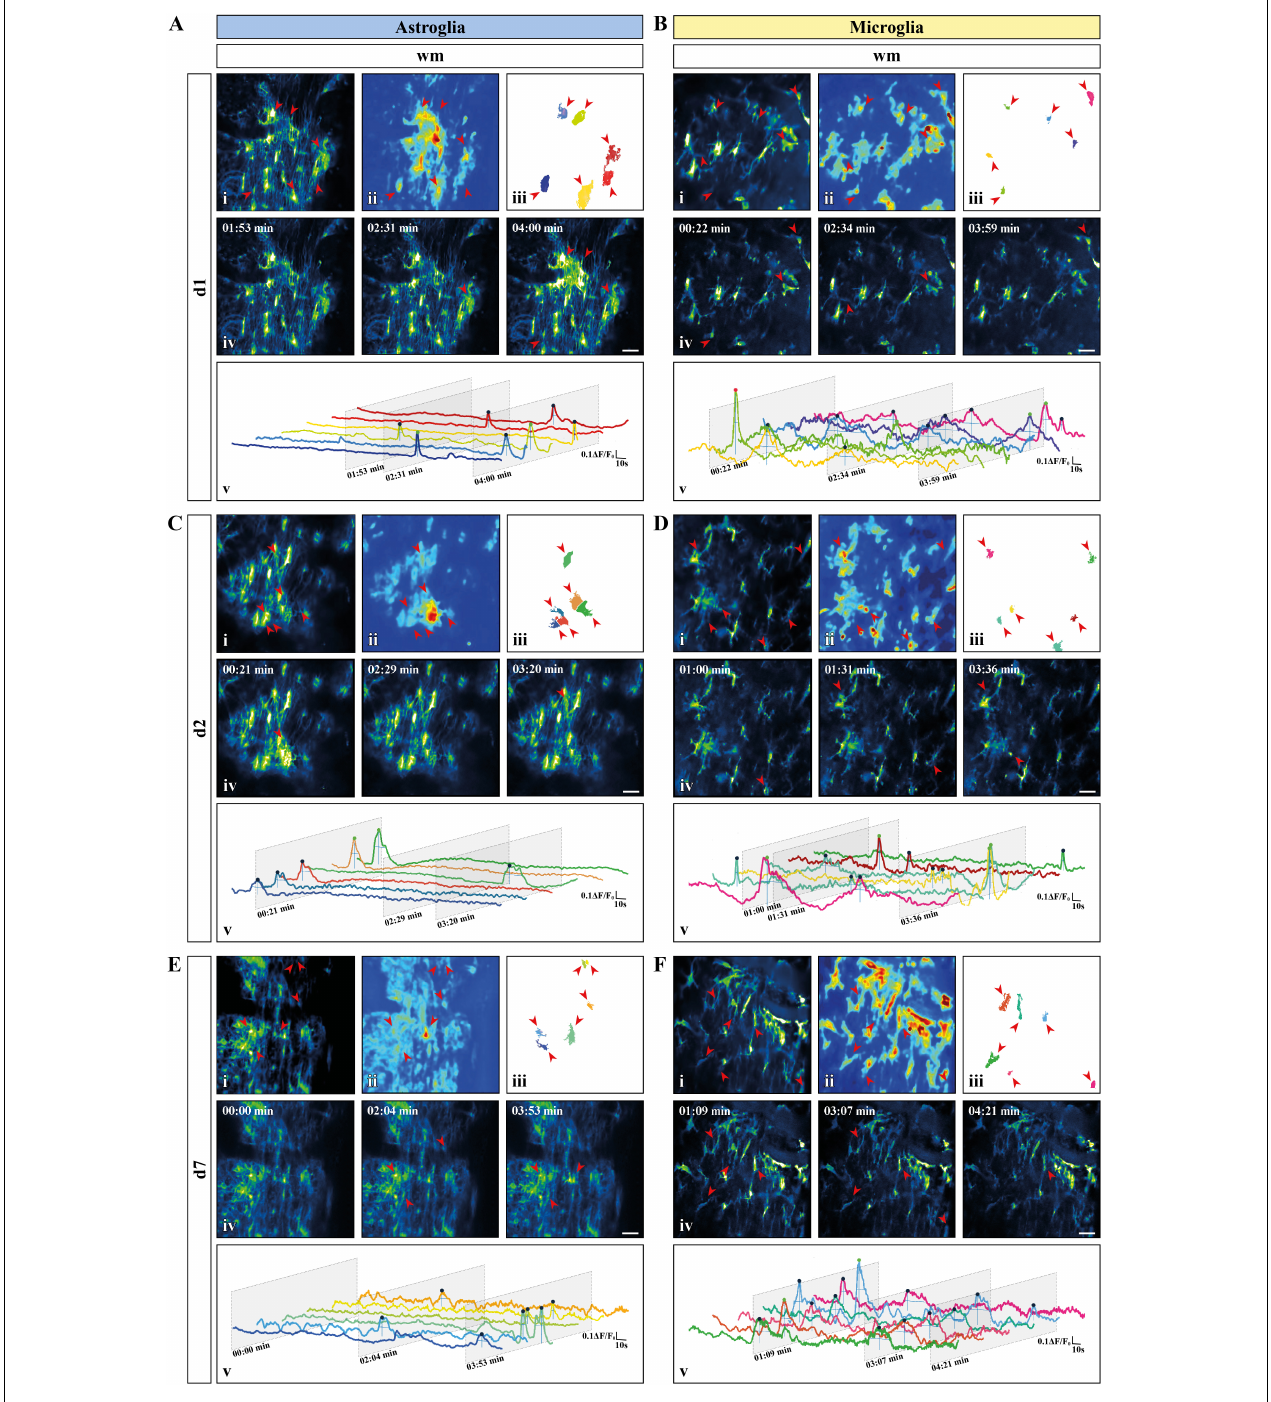
FIGURE 4 | Activity-based in vivo Ca 2 + signaling analysis for astro- and microglia after chronic window implantation. (A–F) Representative Ca 2 + signaling analysis for (A,C,E) astroglia and (B,D,F) microglia monitored in vivo [ (A,B) day one ( d1 ); (C,D) day two ( d2 ); (E,F) day 7 ( d7 )] using the custom-made MATLAB-based software MSparkles. Maximum-intensity projection of GCaMP3 signals for representative FOV [scale bar, 20 µ m; (i)] over the entire recording time (up to 5 min), absolute intensity projection (ii) and selected regions of activity [ROAs; (iii)] automatically detected using variations in the absolute intensity. Red arrows indicate location of the selected ROAs with representative time frames from the selected recordings [scale bar, 20 µ m; (iv)]. Red arrows indicate the location of the selected ROAs if active in the displayed time frame. Normalized relative fluorescence intensity traces over time ( (cid:49) F/F 0 ) for the selected ROAs (v) with trace colors matching the colors of the selected ROAs and oblique sections indicating the time points chosen for display. Automatically detected signals were pinpointed and color coded based on signal strength ( µ + σ ≤ (cid:49) F/F 0 ≤ µ + 2 σ , blue; µ + 2 σ < (cid:49) F/F 0 ≤ µ + 3 σ , green; (cid:49) F/F 0 > µ + 3 σ , red) calculated on the mean value ( µ ) and the corresponding standard deviation ( σ ) over all